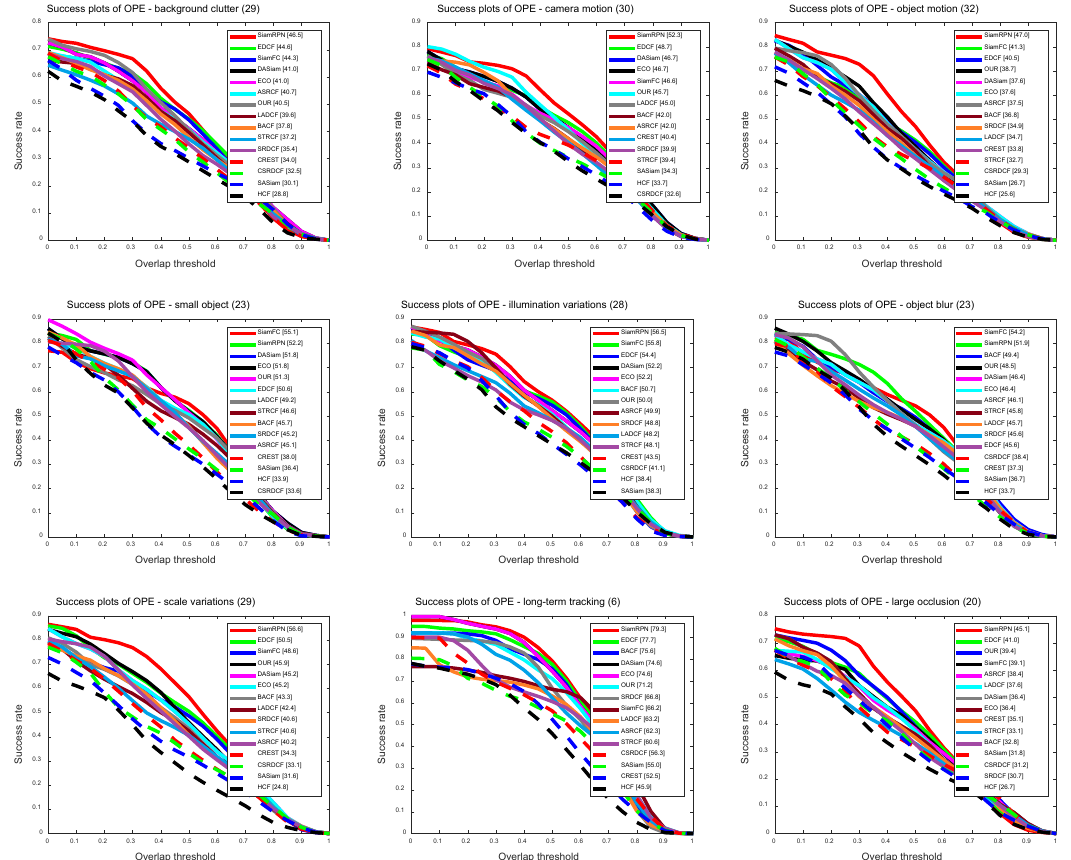
Figure 8. Precision plots based on tracking results on the UAVDT dataset in nine sequence attributes, including: background clutter (29), camera motion (30), object motion (32), small object (23), illumination variations (28), object blur (23), scale variations (29), long-term tracking (6), and large occlusion (20). The legend of distance precision is the threshold scores at 20 pixels. The proposed algorithm performs well against state-of-the-art